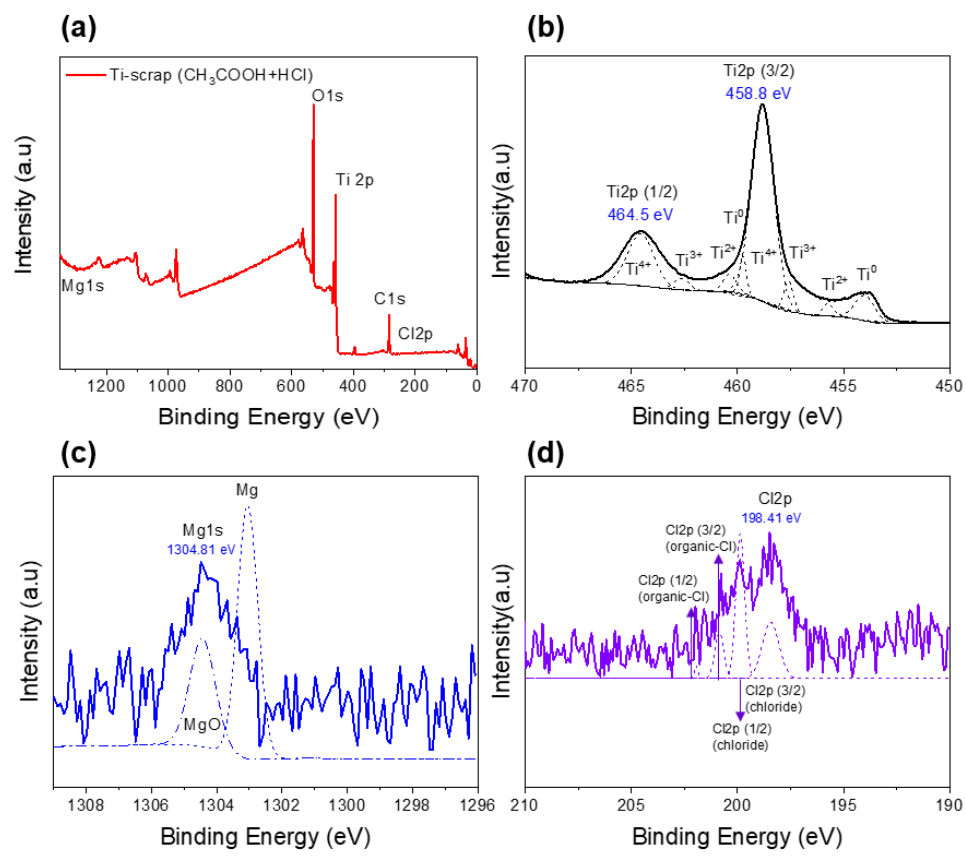
Figure 6. XPS results of Ti scrap with deoxidation and conventional washing: full spectrum ( a ) and designated elements ( b – d ).